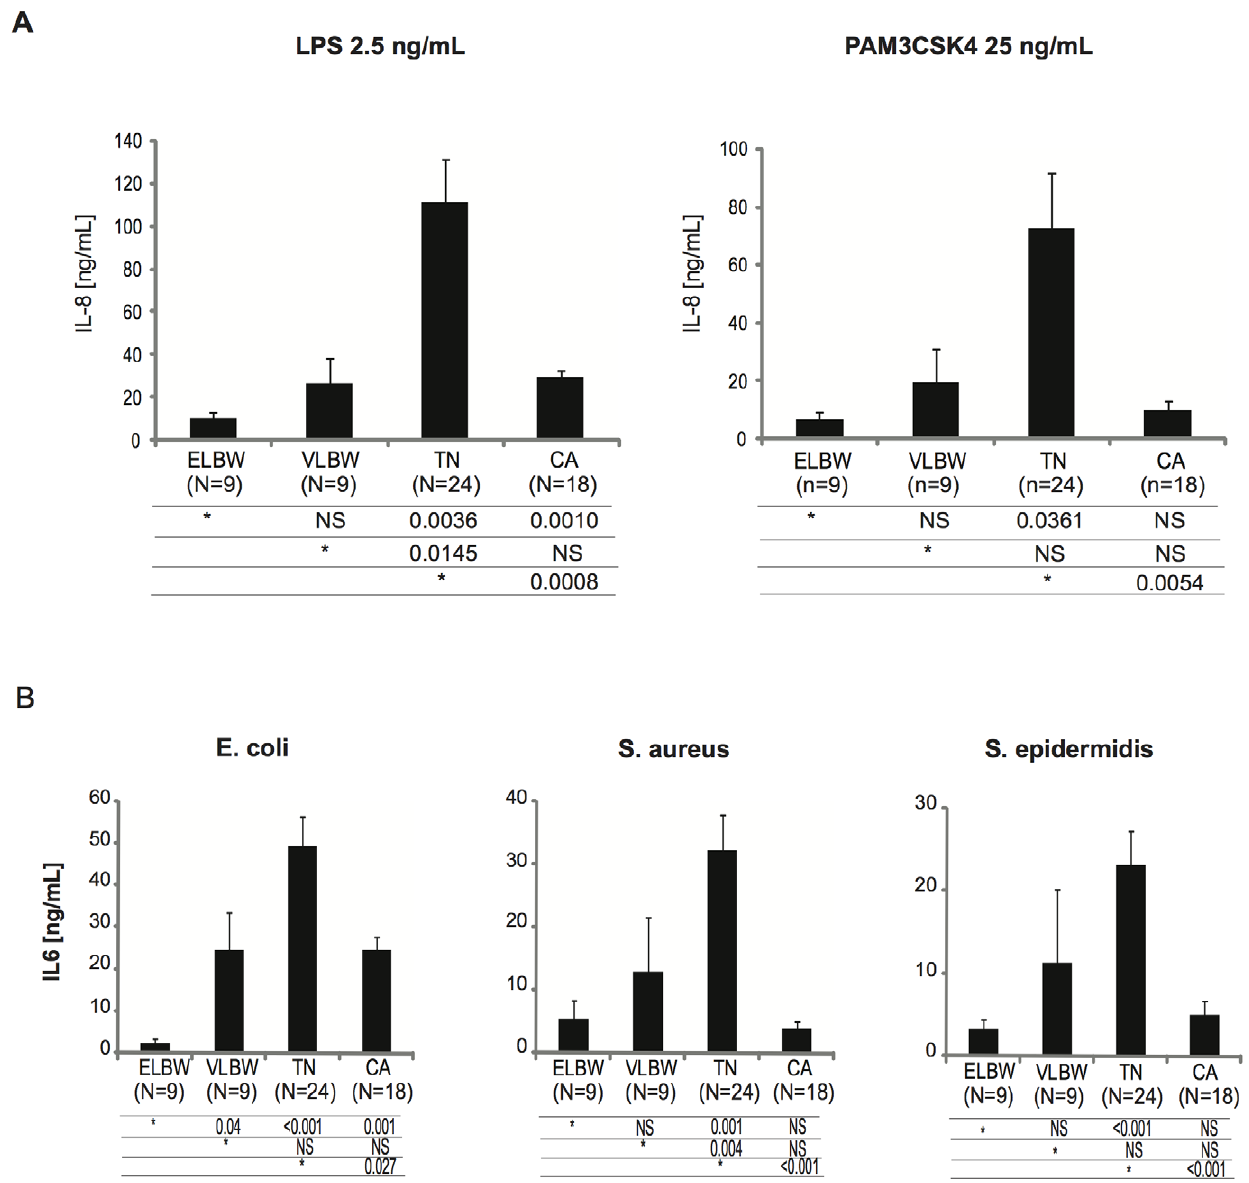
Figure 3. Whole blood response to bacterial agonists and heat-killed bacteria. (A) Whole blood obtained from subjects of the four groups (ELBW, extremely low birth weight premature infants born before 28 wks of gestational age, N=9; VLBW, very low birth weight premature infants born between 28–32 wks of gestational age, N=9; TN, term newborns, N=18; CA, control adults, N=24) were stimulated 12 hrs with LPS (2.5 ng/mL) or PAM 3 CSK 4 (25 ng/mL). Interleukin-8 levels (mean 6 SEM) were quantified by ELISA in conditioned plasma. On each line, a reference group (*) is compared to other groups and respective P value expressed using Mann-Whitney U test. (B) Whole blood obtained from subjects of the four groups (ELBW, extremely low birth weight premature infants born before 28 wks of gestational age, N=9; VLBW, very low birth weight premature infants born between 28–32 wks of gestational age, N=9; TN, term newborns, N=18; CA, control adults, N=24) were stimulated 12 hrs with heat-killed bacteria (3.7 6 10 6 E. coli , S. epidermidis , and 1.56 6 10 6 S. aureus ). Interleukin-6 levels (mean 6 SEM) were quantified by ELISA in conditioned plasma. On each line, a reference group (*) is compared to other groups and respective P value expressed using Mann-Whitney U test.